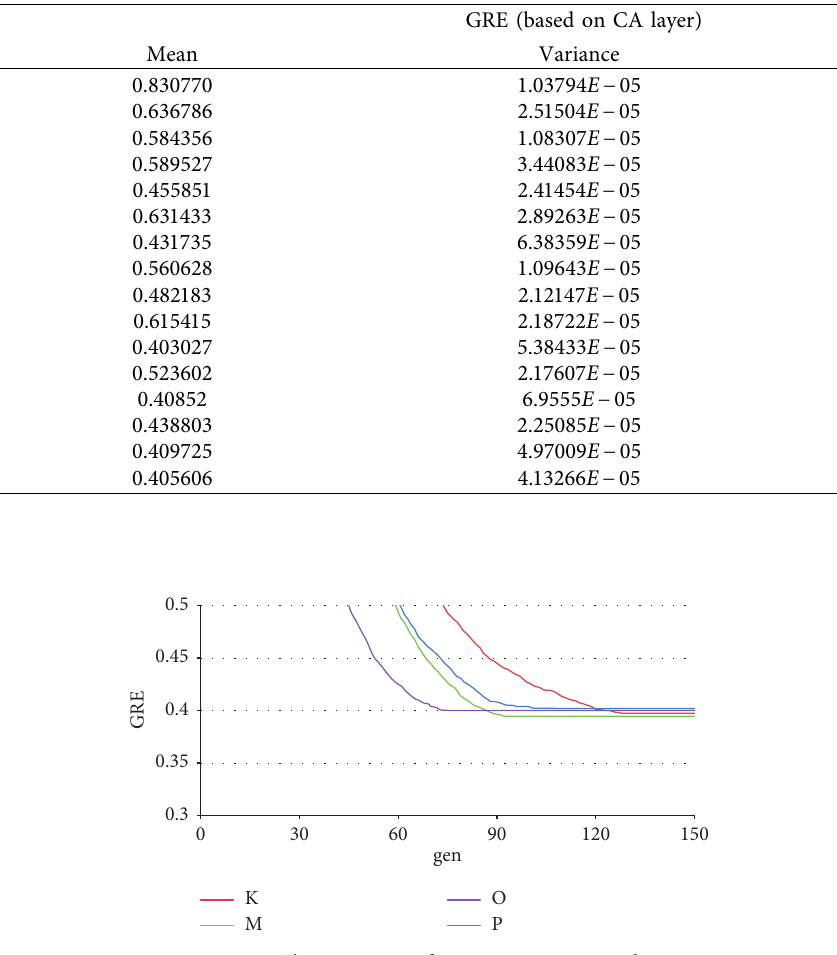
Figure 14: The iterations of Groups K, M, O, and